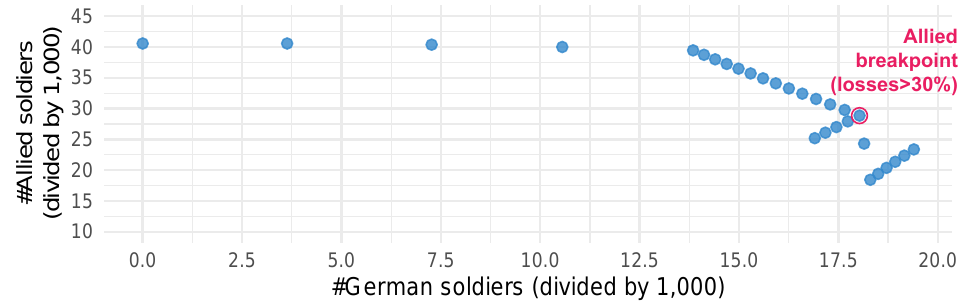
Figure 13. Scatter plot obtained from the predictive block for increasing effectiveness as an alternative COA, applying an increased effectiveness of 25%. This shows how the other COA does not prevent the invasion of the island (the Allied breakpoint on the 8th day defines the Allied